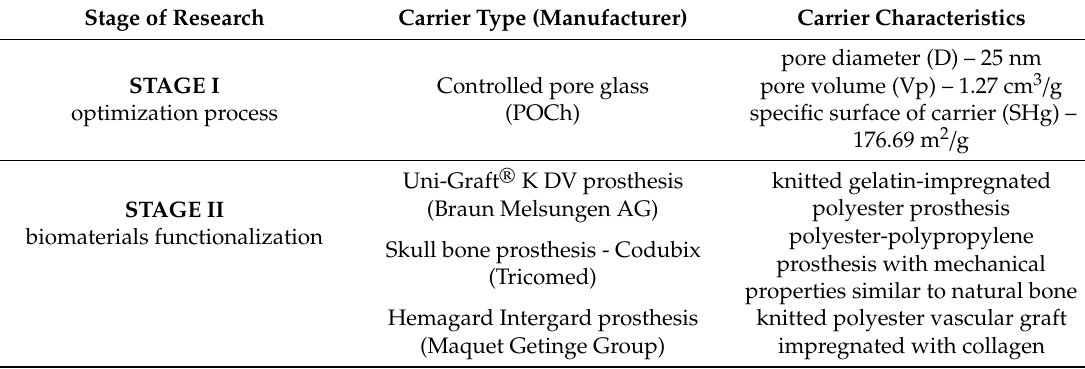
Table 1. Characterization of carriers modified by inhibitors of proteolytic